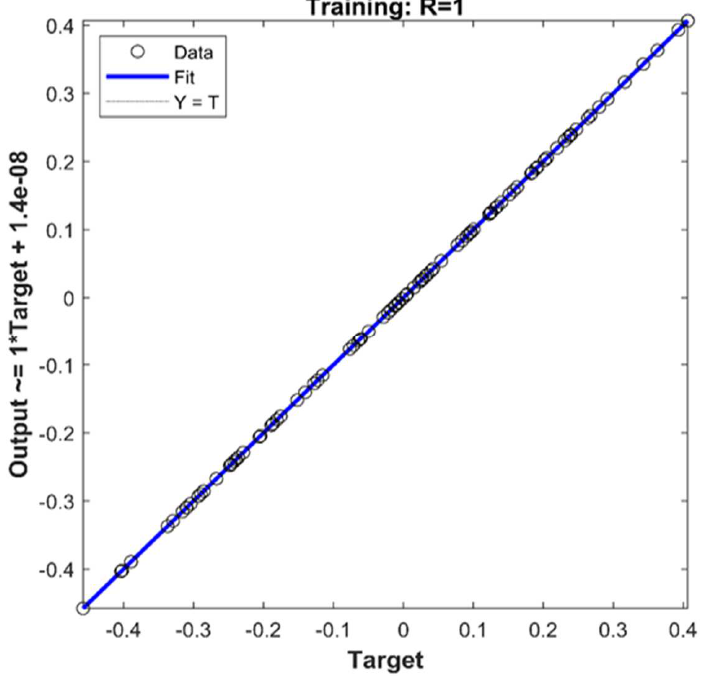
Figure 8. The regression model training analysis’s prediction error.